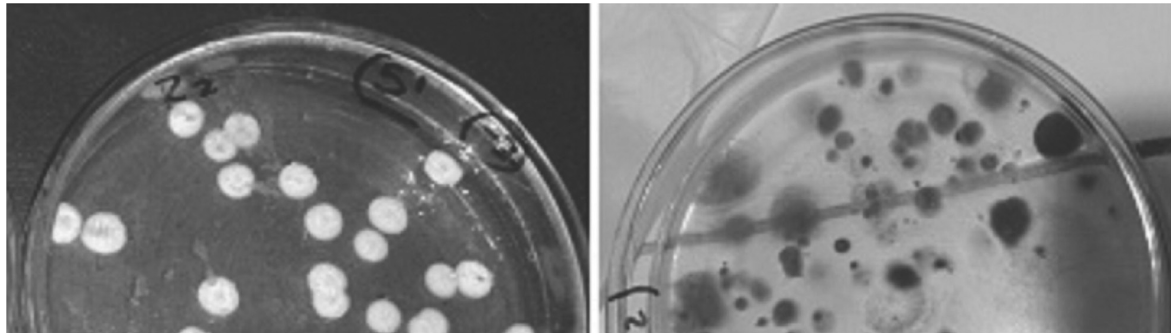
Figure 6. Images of microbiological cultures developed in samples sterilized by both heat treatments.